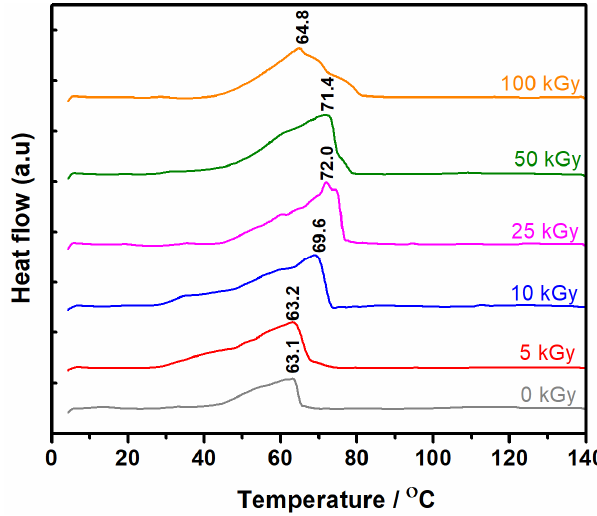
Figure 6. DSC curves for non ‐ crosslinked and crosslinked collagen gels.